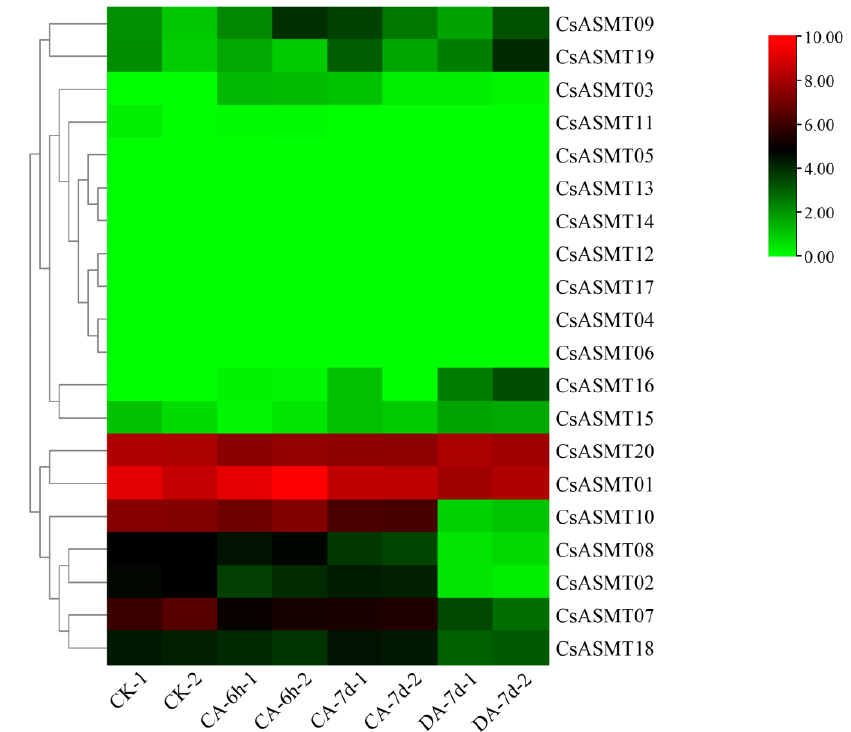
Figure 7. Heat map of FPKM expressions of C. sinensis ASMT genes under cold stress based on RNA-Seq data. FPKM values were all log2-processed, and heat map clusters were constructed. The color scale representing relative expression values is shown on the left, CA: 10 °C treatment, DA: room-temperature recovery.